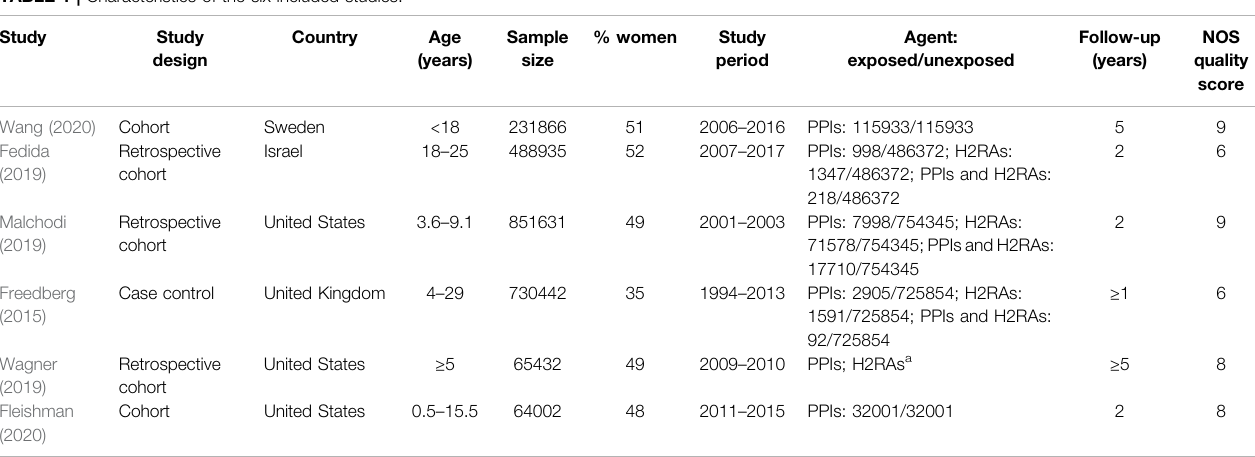
TABLE 1 | Characteristics of the six included